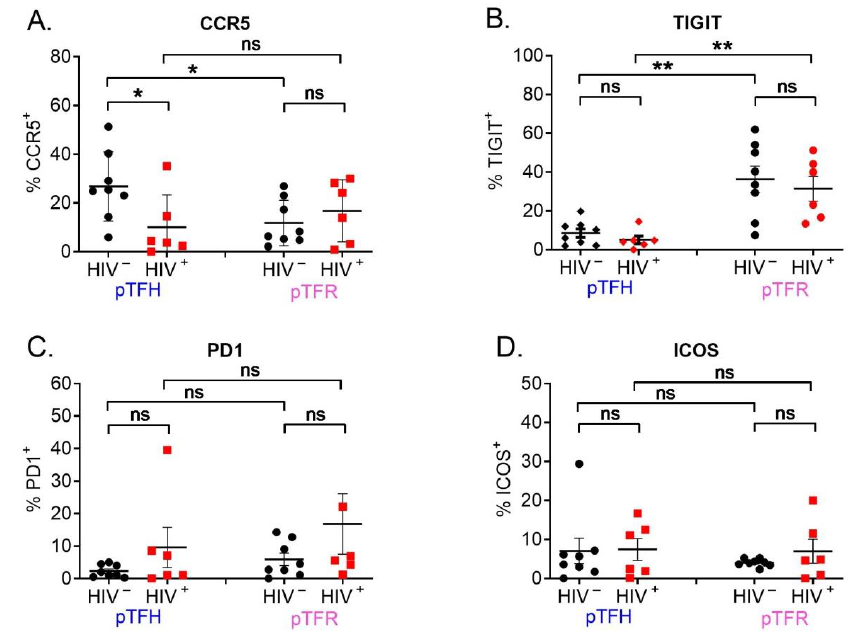
Figure 5. Expression of surface markers of pTFH and pTFR cells. ( A – D ) Quantification of the percentage of cells expressing CCR5, TIGIT, PD1, or ICOS on pTFR and pTFH cells, respectively. HIV− ( n = 8, mean ± SEM). HIV+ (in red, n = 6, mean ± SEM) (Mann – Whitney U test). ( A , B ) In both pTFH and pTFR cells, the percentage of TIGIT-expressing cells was similar in HIV-infected and non-infected individuals. In HIV-infected and non-infected individuals, the expression of TIGIT was higher in pTFR than in pTFH cells. ( C,D ). In both pTFH and pTFR cells, the percentage of cells expressing PD1/ICOS was similar in HIV-infected and non-infected participants of the MACS. (ns: p>0.05, *: p ≤ 0.05, **: p ≤ 0.01)